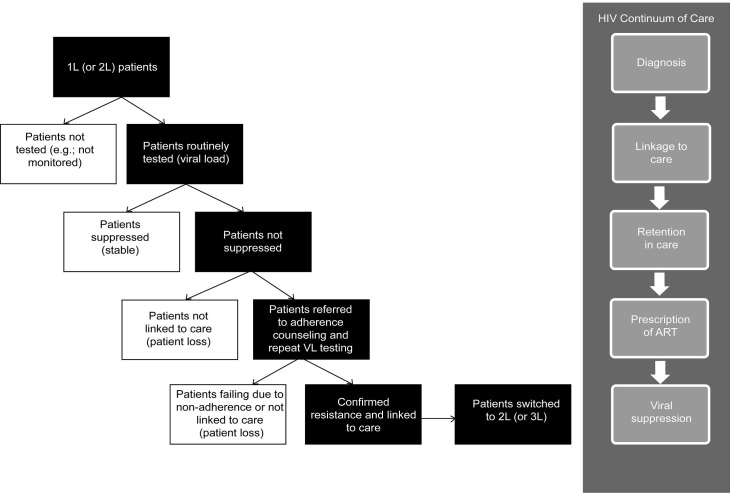
Patient pathway.